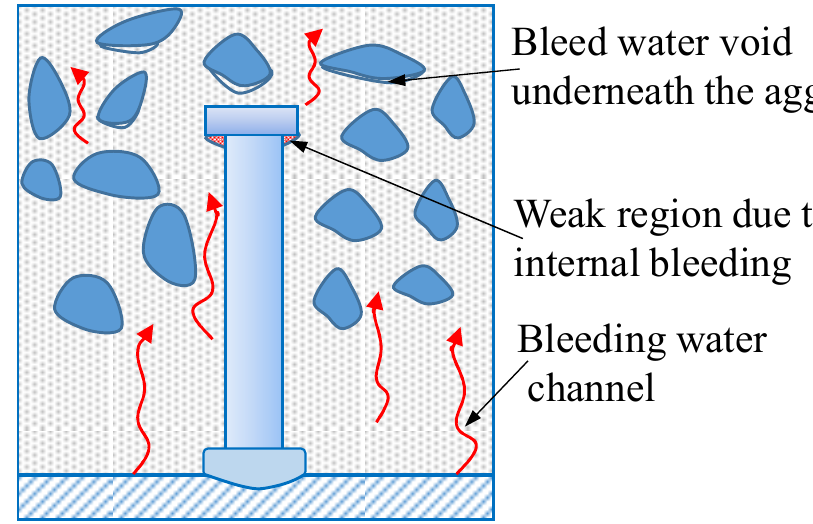
Figure 10. Weak region due to internal bleeding in the concrete slab.